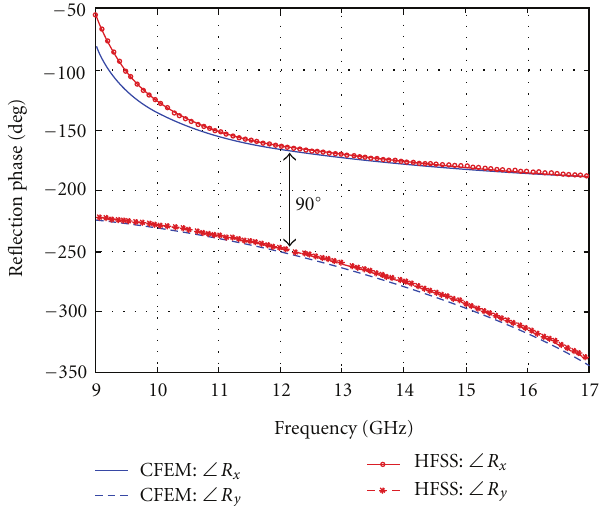
Figure 12: Reflection phases of two orthogonal field components of the circular polarizer, calculated using CFEM and